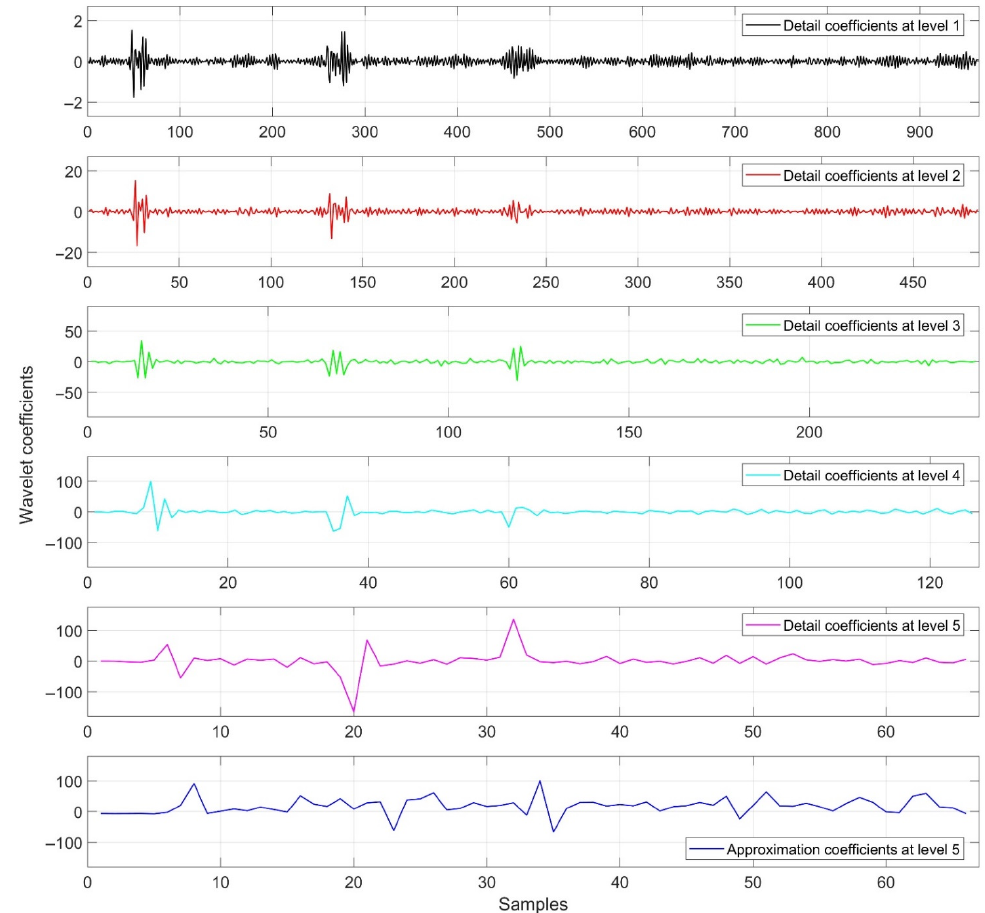
Figure 3. Wavelet coefficients up to level 5 of the corrupted EEG shown in the top panel of Figure 2 using Daubechies wavelet with vanishing moment as 4.